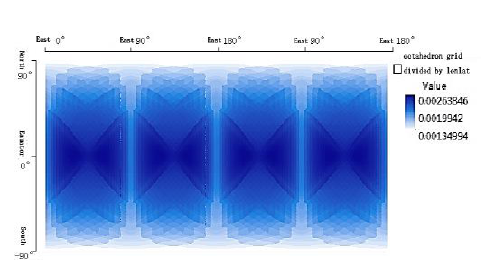
Figure 20. Distribution of electrical potential energy of spherical diamond discrete grids octahedron grid divided by mixed method